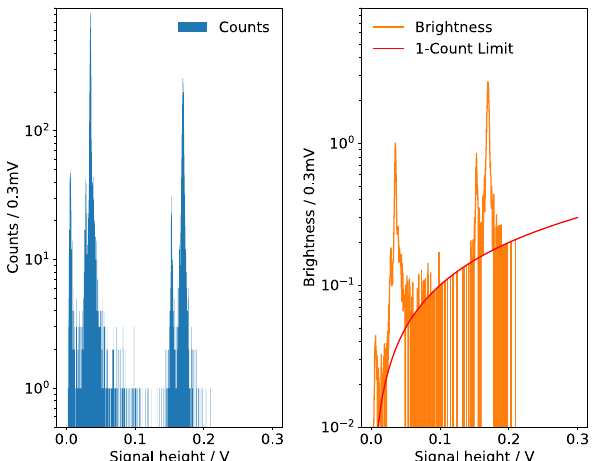
Fig. 7 Histogram of χ 2 of a single detector channel. The plotted red range contains (cid:4) 99 . 7% of all raw events. The filtered region after the pulse shape filter still encompasses (cid:4) 97 . 6% of all raw events. Also depicted is the skewed Gaussian fit from which the pulse shape filter is calculated FOM at the level of single events, defined